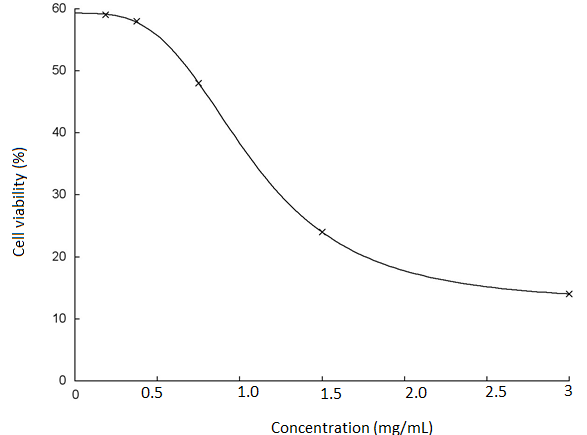
Figure 8. Graph of the percentage of cell viability of gingival fibroblasts in different concentrations of cinnamon NPs.